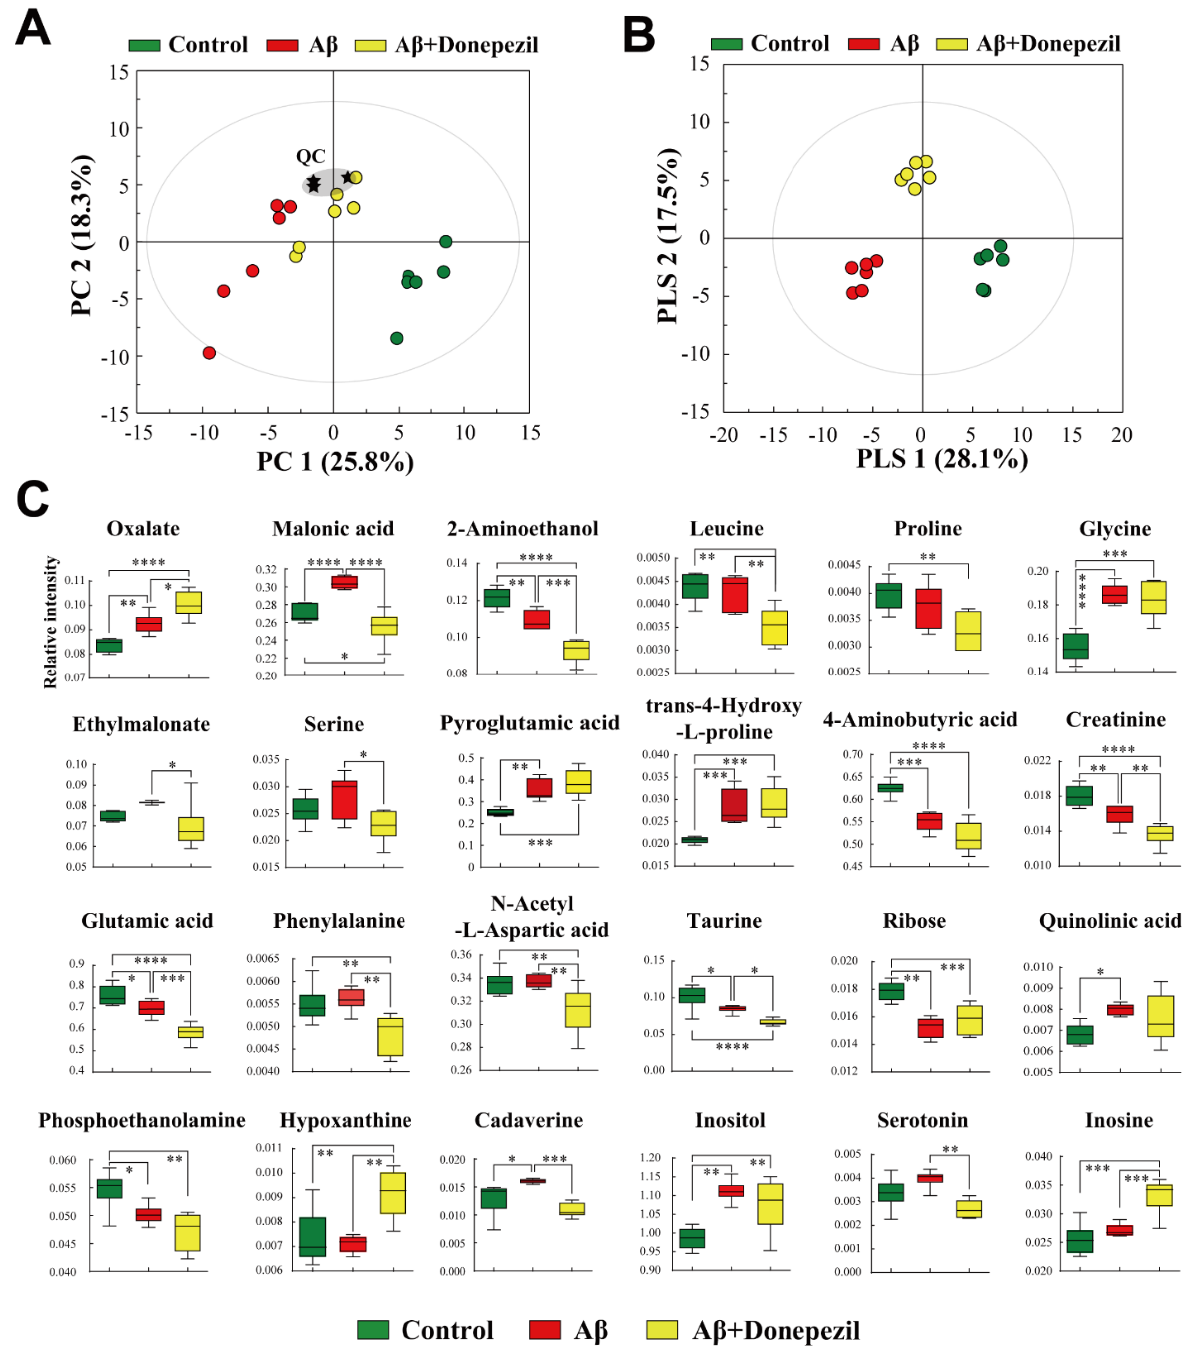
Figure 5. ( A ) Principal component analysis (PCA) score plot based on GC-MS data sets from brain tissues. ( B ) Supervised PLS-DA score plot derived from the GC-MS data from brain tissues. ( C ) Box plots of significantly different metabolites in the brain tissues. *, p < 0.05; **, p < 0.01; ***, p < 0.001; ****, p < 0.0001. A false discovery rate (FDR) of 5% was applied to all tests to correct for multiple testing. Variables that significantly contributed to the discrimination between the control and A β groups were selected based on a VIP > 1.0 and p < 0.05. Brain tissues injected with A